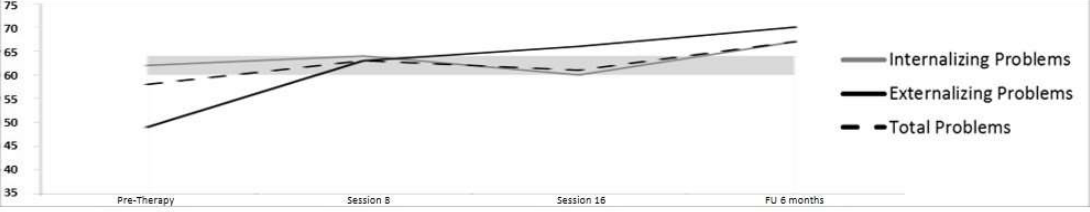
Figure 4: Deborah’s Youth Self Report (YSR) scales T-scores Note . FU = follow-up. YSR = Youth-Self Report (Achenbach, 1991). The grey area indicates the borderline range. Above the grey area scores are considered in the clinical range, below in the normal